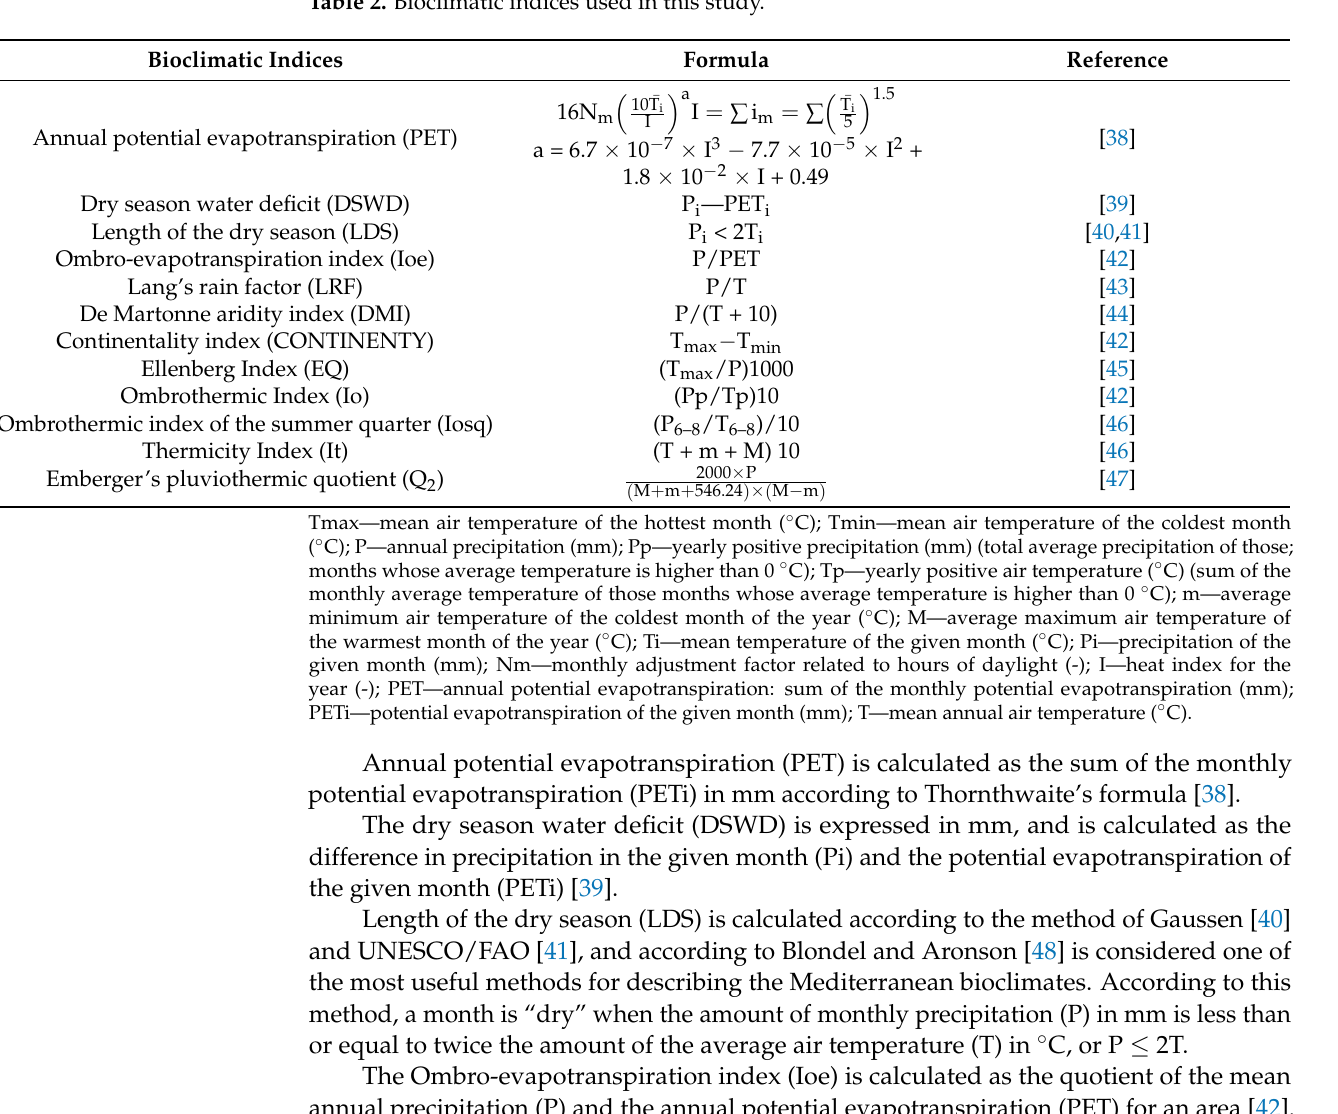
Table 2. Bioclimatic indices used in this